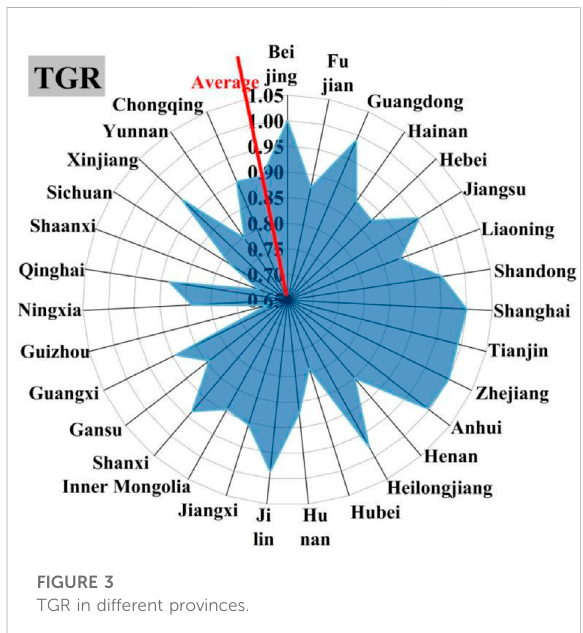
FIGURE 3 TGR in different